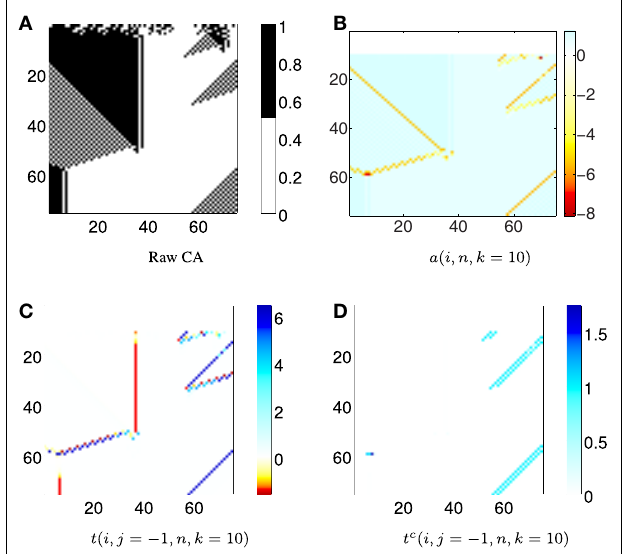
FIGURE 7 | Local information dynamics in rule ψ par . Local information dynamics in rule ψ par with r = 3 for the raw values displayed in (A) (black for “1,” white for “0”). Seventy-five time steps are displayed for 75 cells, starting from an initial random state. Notice that a short initial transient occurs after that the emergent structures arise. For the spatiotemporal information dynamics plots (B–D) , we use a history length k = 10 (therefore, the measures are undefined and not plotted for n ≤ 10), and all units are in bits.We have (B) Local active information storage a ( i , n , k = 10); (C) Local apparent or pairwise transfer entropy one cell to the left t ( i , j =− 1, n , k = 10); and (D) Local complete transfer entropy one cell to the left t c ( i , j =− 1, n , k = 10). After Lizier et al.